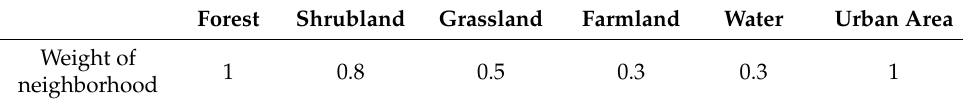
Table A2. The weight of neighborhood in FLUS model simulation.